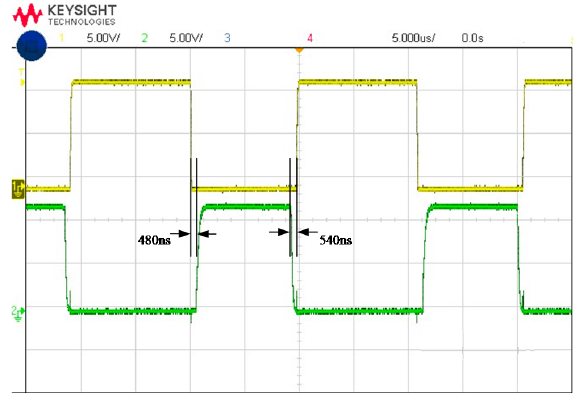
Figure 19. Power MOS tube driving waveform when the charging and discharging circuit is charged.